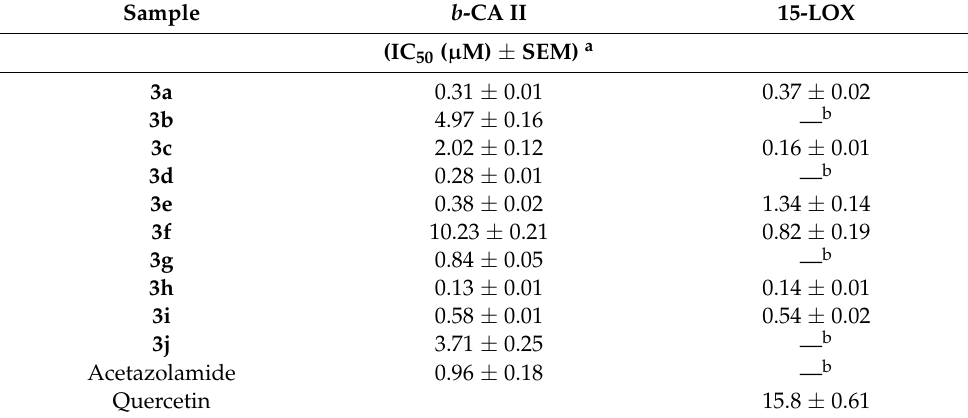
Table 1. In vitro b -CAII and 15-LOX inhibition by novel compounds 3a – j . The presented values are IC 50 ( µ